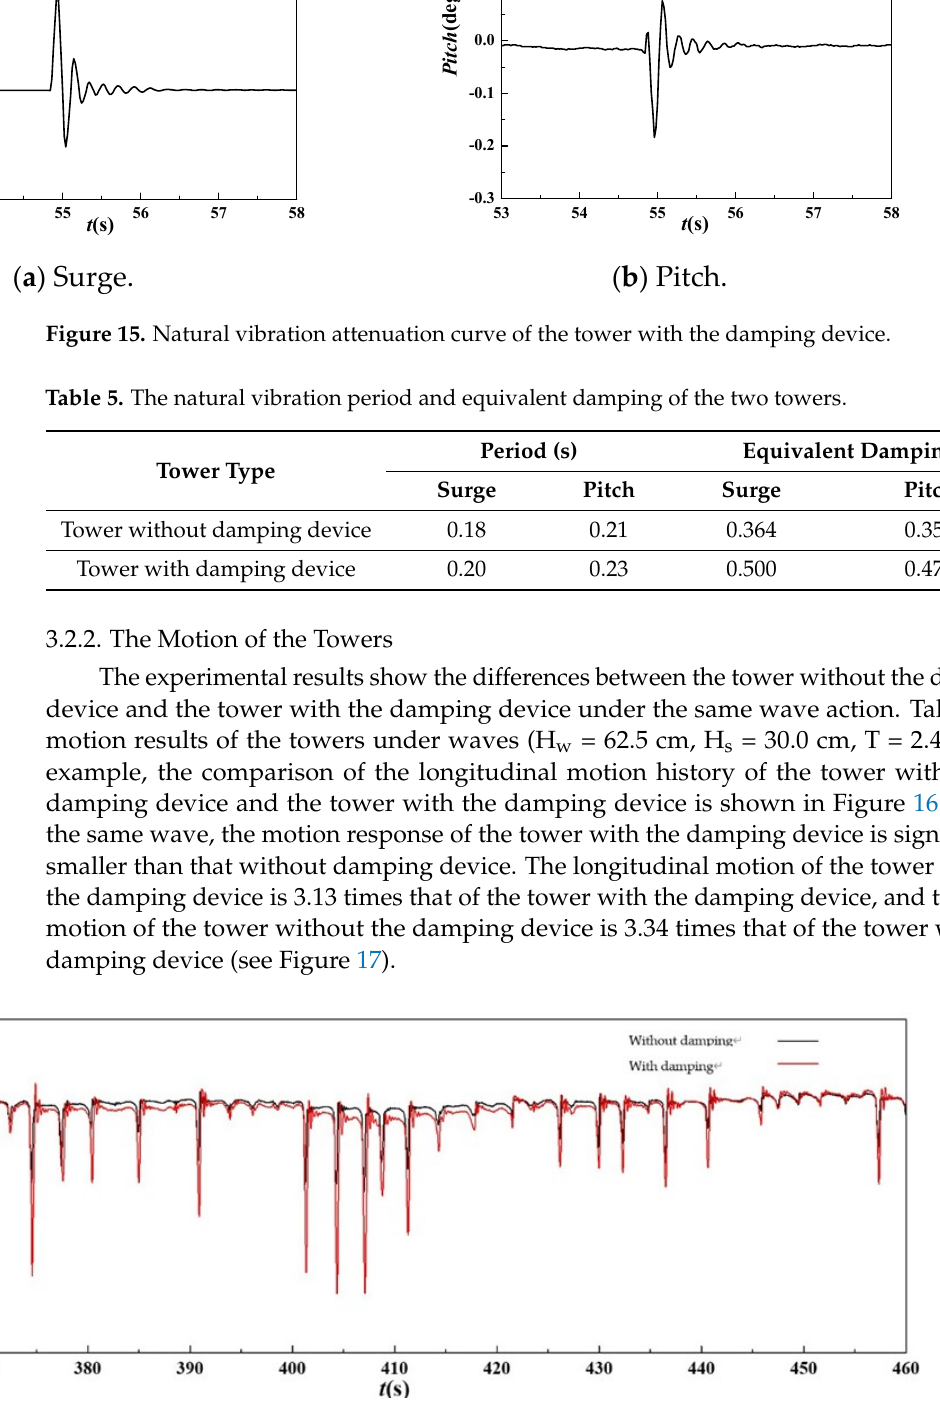
Figure 16. Comparison diagram of the surge history of the towers with and without the damping device (H w = 62.5 cm, H s = 30.0 cm, T = 2.45 s).